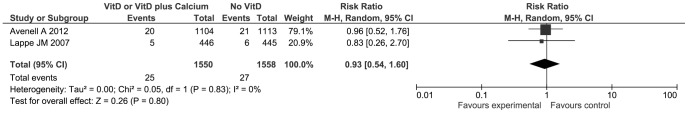
Forest plot of vitamin D supplementation and breast cancer incidence.Administration mode on treatment effects. Legend to Figure 4. M–H, Mantel-Haenszel; 95% CI, 95% confidence interval; df, degrees of freedom.